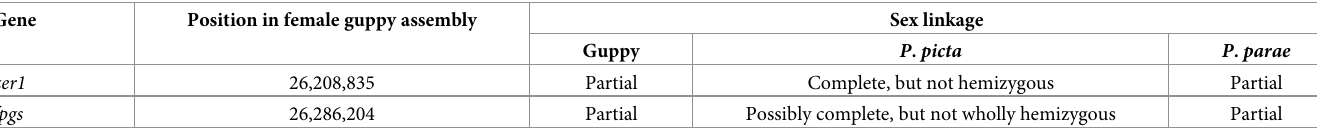
Table 1. Results of genetic mapping or genotyping of two guppy PAR genes in two Micropoecilia species. Gene Position in female guppy assembly Sex linkage Guppy P . picta P . parae zer1 26,208,835 Partial Complete, but not hemizygous Partial fpgs 26,286,204 Partial Possibly complete, but not wholly hemizygous